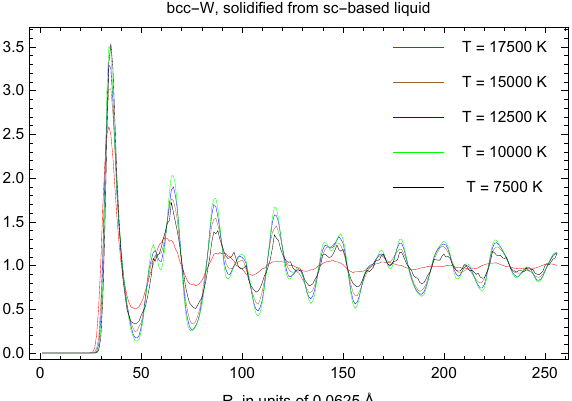
Figure 16. Radial distribution functions (RDFs) of the final states of the solidification of liquid W at ∼ 1200 GPa at higher